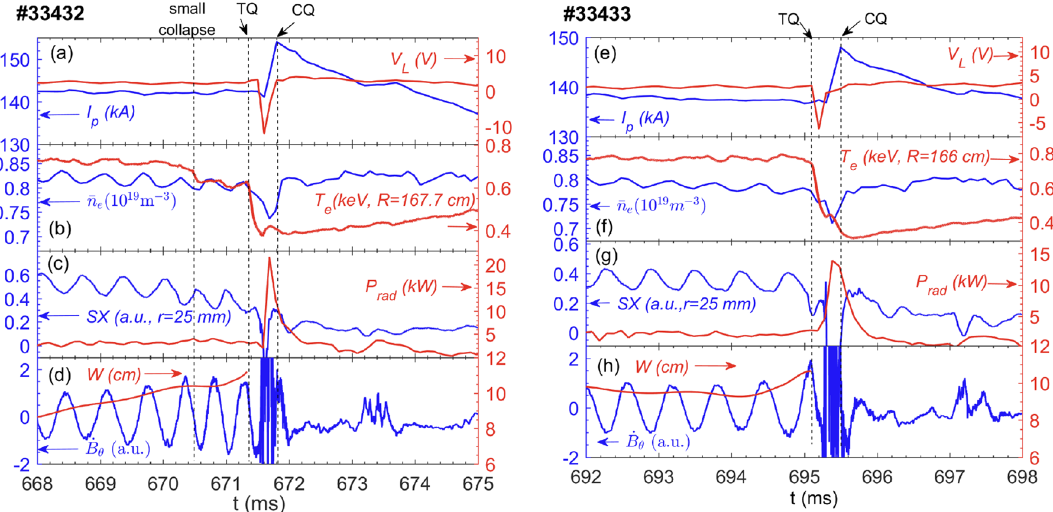
Figure 2. ( a )–( d ) Time evolutions of discharge parameters for #33432 with a small collapse prior to the TQ. The small collapse, TQ and CQ occur at 670.45 ms, 671.37 ms and 671.81 ms, respectively. ( e )–( h ) Time evolutions of discharge parameters for #33433 without small collapse prior to the TQ. The TQ and CQ occur at 695.1 ms and 695.5 ms, respectively. Plotted in ( a ) and ( e ) are plasma current and loop voltage, ( b ) and ( f ) central line-averaged density and core electron temperature, ( c ) and ( g ) Soft X-ray radiation with the chord through r = 25 mm and total radiated power, ( d ) and ( h ) Mirnov coil signal ( ˙ B θ ) and island width ( W